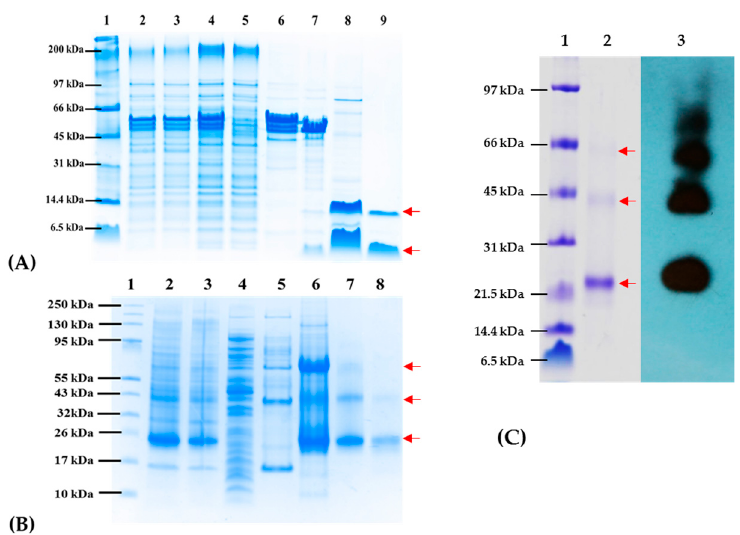
Figure 3. Purification steps of NG06 ( A ) and NG19 ( B ) and immunodetection by Western Blot ( C ). Line 1A, 1B, and 1C: Molecular weight marker, Line 2A and 2B: total fraction, Line 3A and 3B: insoluble fraction, Line 4A and 4B: soluble fraction, Line 5A and 5B: non-bound fraction obtained after purification by IMAC, Line 6A, and Line 6B: bounded fraction obtained after purification by IMAC, Line 7A: fraction bound after second IMAC, Line 7B: Refolding/SEC fraction, Line 8A: unbound fraction after second IMAC, Line 9A, 8B, and 2C: fraction obtained after SEC. Line 3C: Immunodetection by Western blot employing NG19 as antigen and NG06 immunized sera. Red arrows point to the purified, oligomeric antigens.